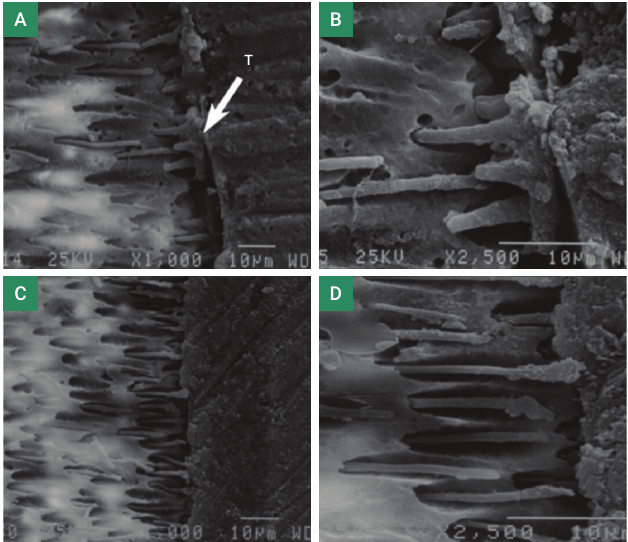
Figure 4. Selected SEM micrographs of resin-dentin interface after Nd:YAG laser irradiation; (A) Single Bond at x1000 magnification; (B) Single Bond at x2500 magnification; (C) OptiBond at x1000 magnification; (D) OptiBond at x2500 magnification. Hybrid layer was formed in limited areas. Resin tags were scarce and irregularly distributed (T).